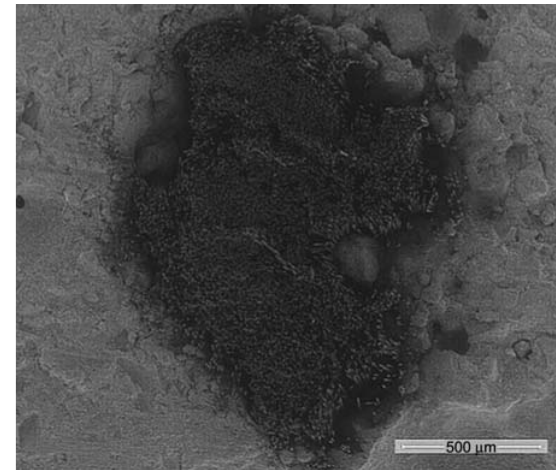
Figure 3 Cross section of carbon fi lament yarn after pull-out.